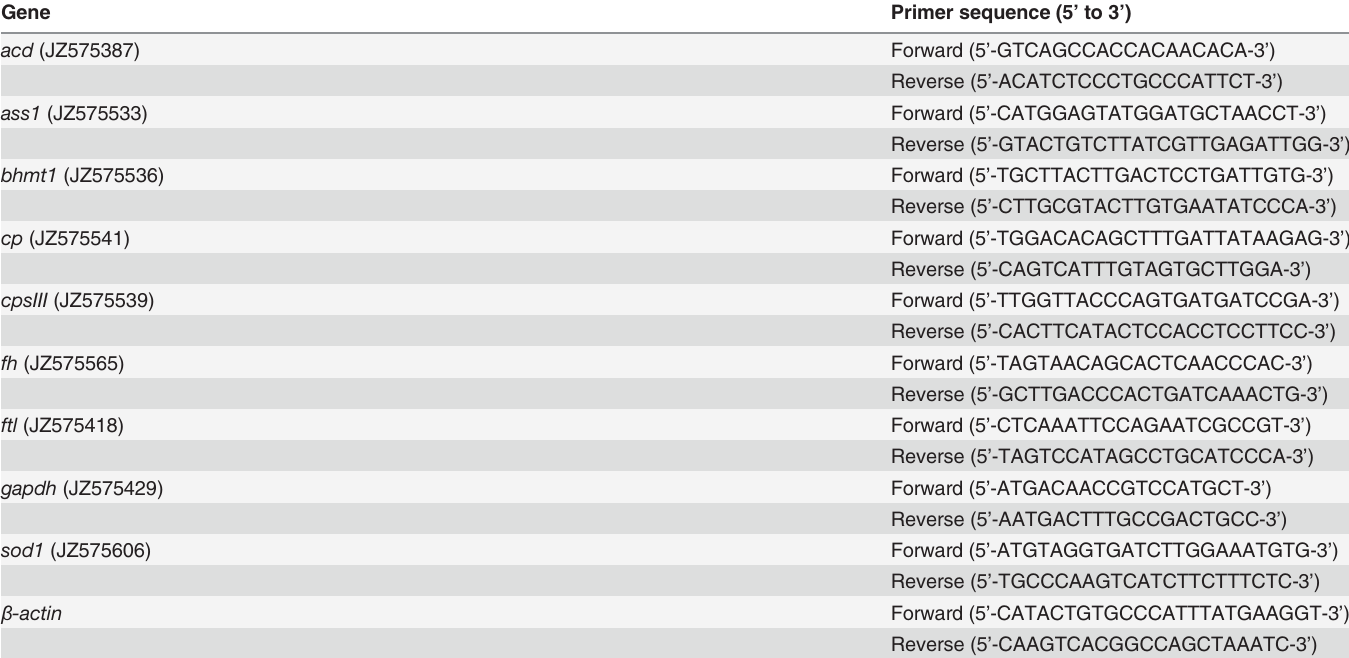
Table 1. Primers used for quantitative real-time PCR on acyl-CoA desaturase ( acd ), argininosuccinate synthetase 1 ( ass1 ), betaine- homocysteine S-methyltransferase 1 ( bhmt1 ), ceruloplasmin ( cp ), carbamoyl-phosphate synthetase III ( cpsIII ), fumarate hydratase ( fh ), ferritin light chain ( ftl ), glyceraldehyde-3-phosphate dehydrogenase ( gapdh ), superoxide dismutase 1 ( sod1 ) from the liver of Protopterus annectens .